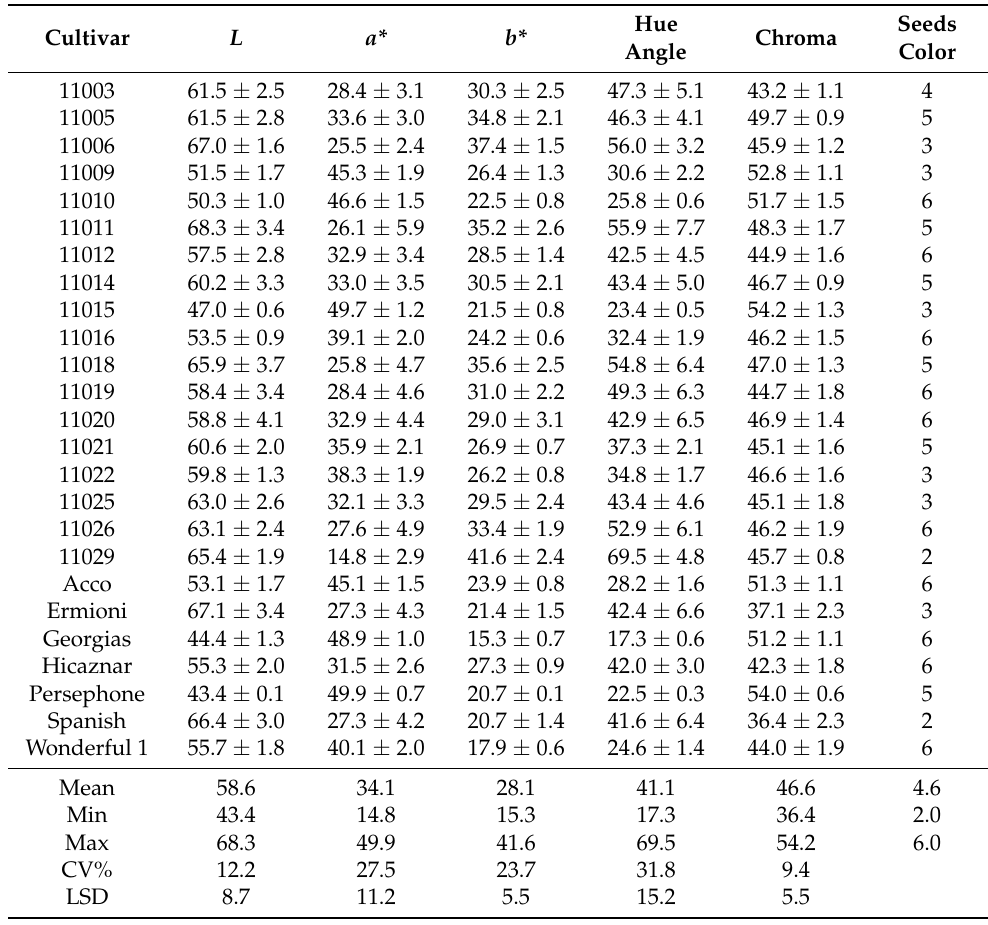
Table 3. Means ( ± sterror) for the fruit skin color parameters L, a*, b*, Hue angle and Chroma and aril color (1, white; 2 = rose-white; 3, rose; 4, dark-rose; 5, rose-red; 6, red; 7, very red) in 26 pomegranate accessions/cultivars. Maximum, minimum, covariate coefficient (CV%) and least significant difference (LSD) are